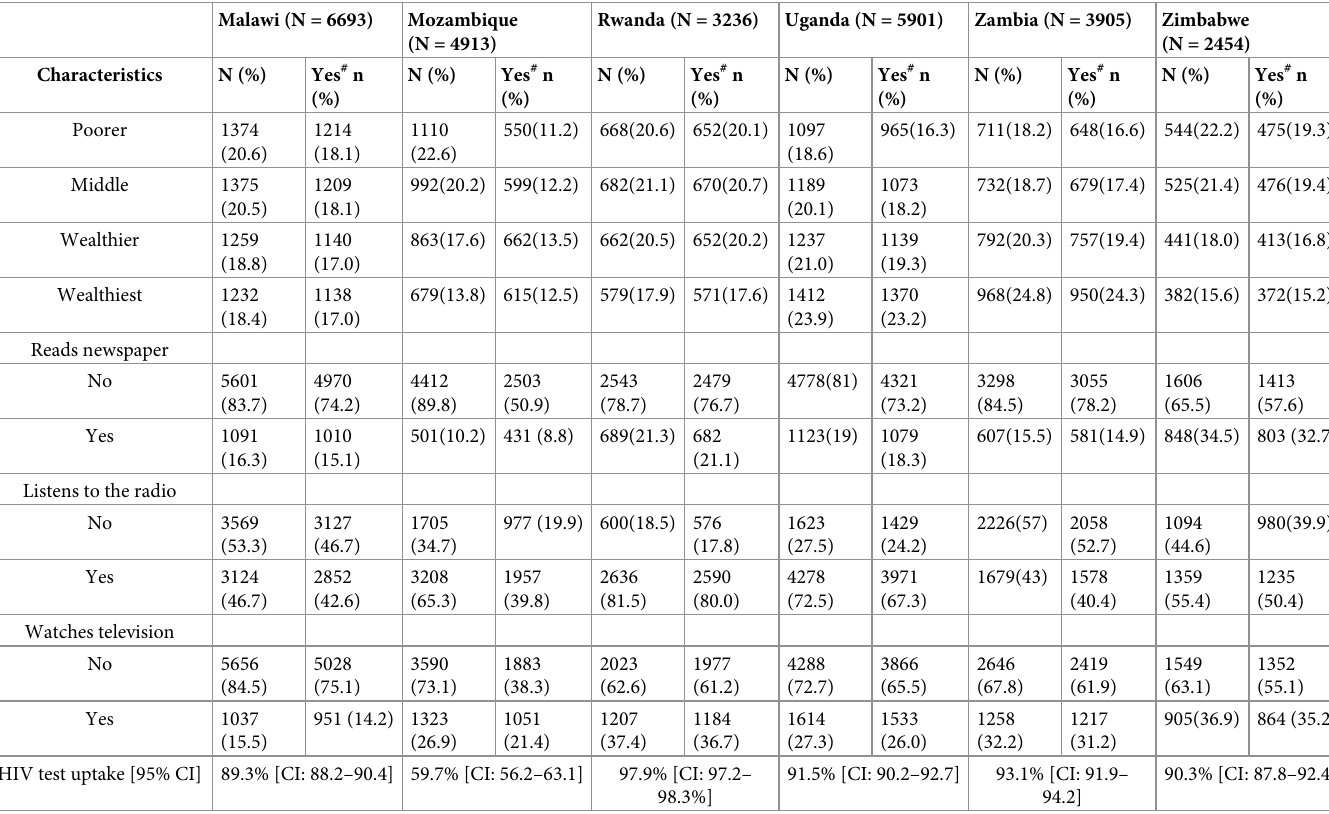
higher education, those who resided in Zambia (n = 1517, 38.9%) and Zimbabwe (n = 1534, 62.5%) reported the highest level of usage of HIV test services during pregnancy, whilst lower levels of usage was reported in Burundi (n = 603, 11.2%), Comoros (n = 111, 8.6%) and Ethio- pia (n = 296, 6.8%)